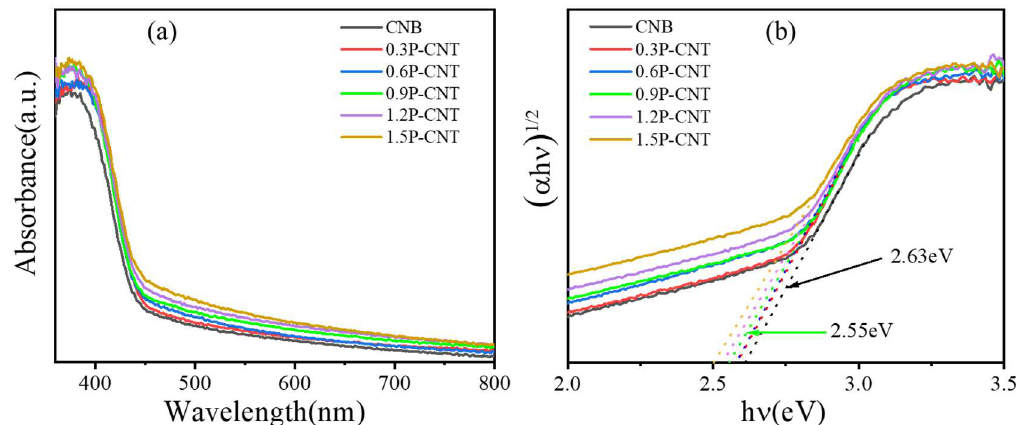
Figure 7. The UV–Vis diffuse reflectance spectra ( a ) and corresponding Tauc plot ( b ) of the CNB, 0.3P-CNT, 0.6P-CNT, 0.9P-CNT, 1.2P-CNT, and 1.5P-CNT samples.